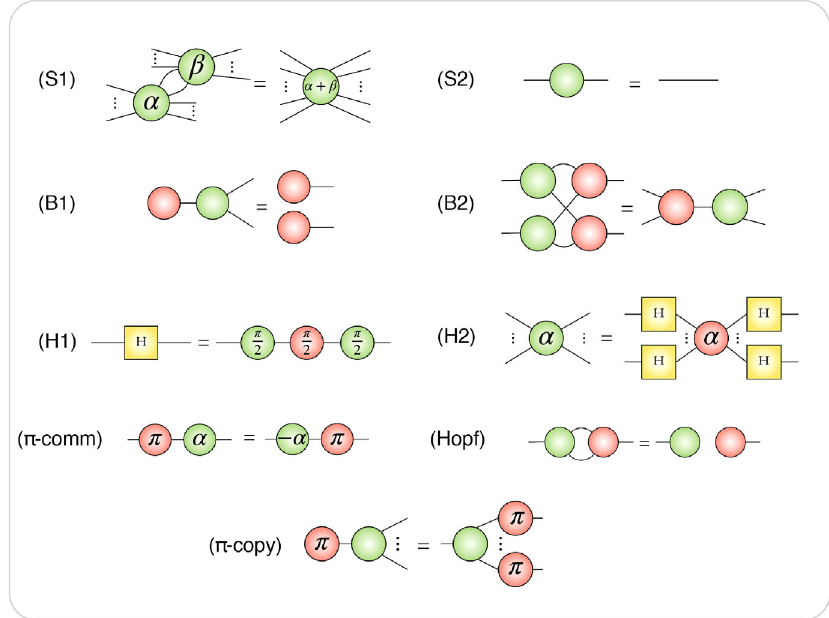
FIG. 4. ZX-calculus rules. This set of reversible axioms or rewrite rules is complete for Clifford